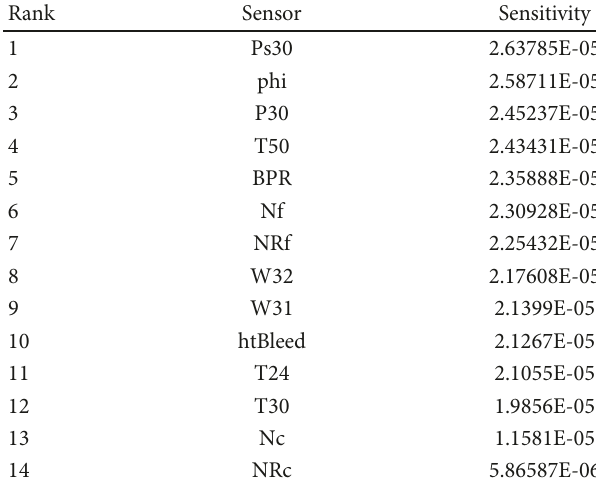
Table 3: Operation regime of the aircraft engine.